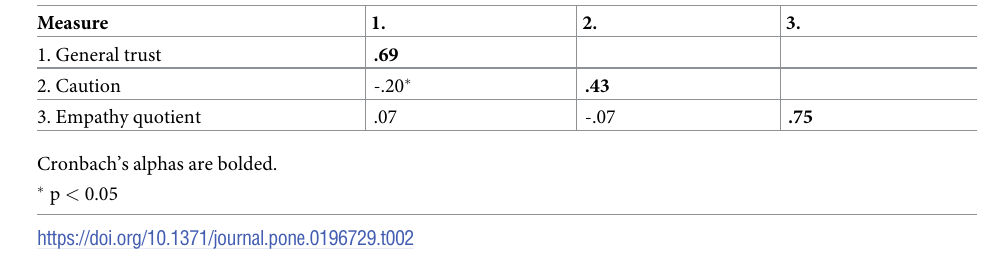
Table 2. Scale reliability and bivariate correlations among judge self-report